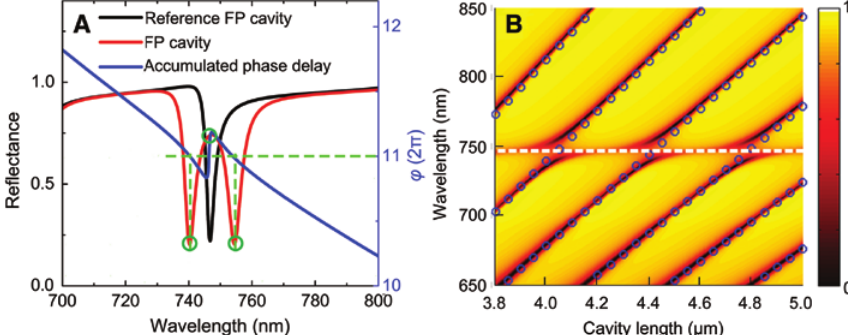
Figure 2: (A) Analytic reflection spectra of the proposed FP cavity (red line) and reference FP cavity (black line) as well as the accumulated phase delay per round trip (blue solid line) in the proposed FP cavity with L = 4415 nm. (B) Analytic reflection spectra of the FP cavity at differ- ent cavity lengths. The white dashed line denotes the resonant wavelength of the plasmon mode on the metallic nanohole array (Figure 1C), and the blue circles denote the reference FP photonic